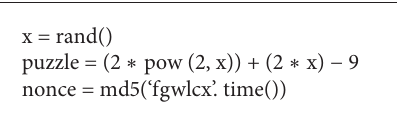
Algorithm 3: STBOA algorithm formulas to generate puzzle, random number, and nonce